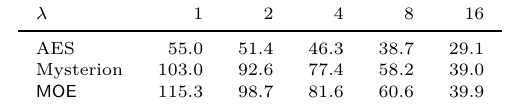
Table 5: Influence of λ on the encryption throughput